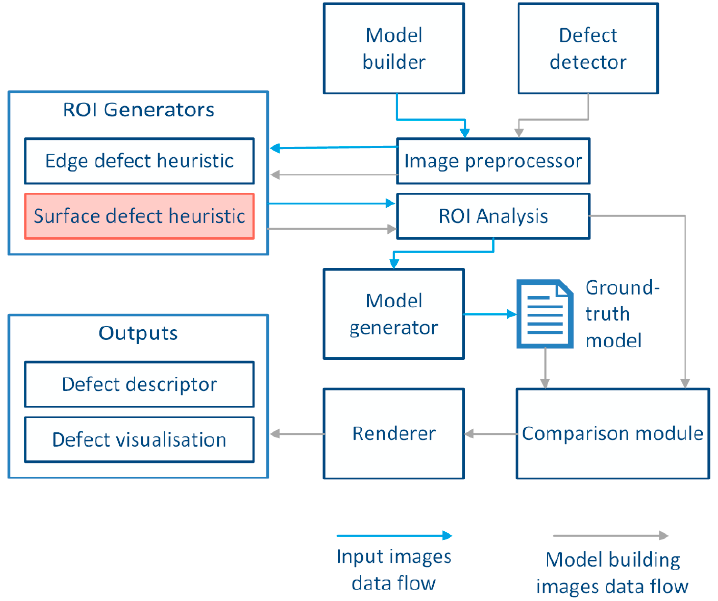
Figure 7. Architecture diagram of the detection system.